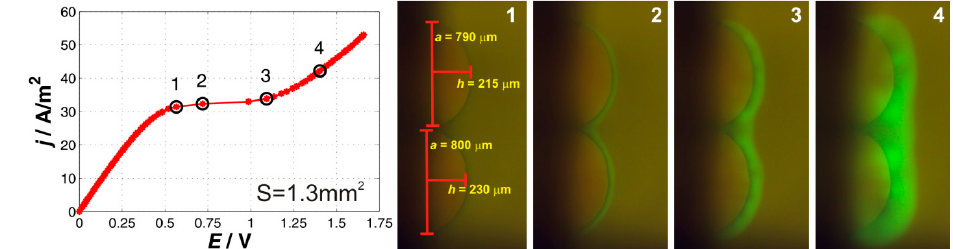
Figure 2. Current–voltage curve and a set of characteristic images for the two-particle membrane. The black circles on the current–voltage curve mark the current densities at which the depicted fluorescent images denoted as 1, 2, 3, and 4 were obtained.